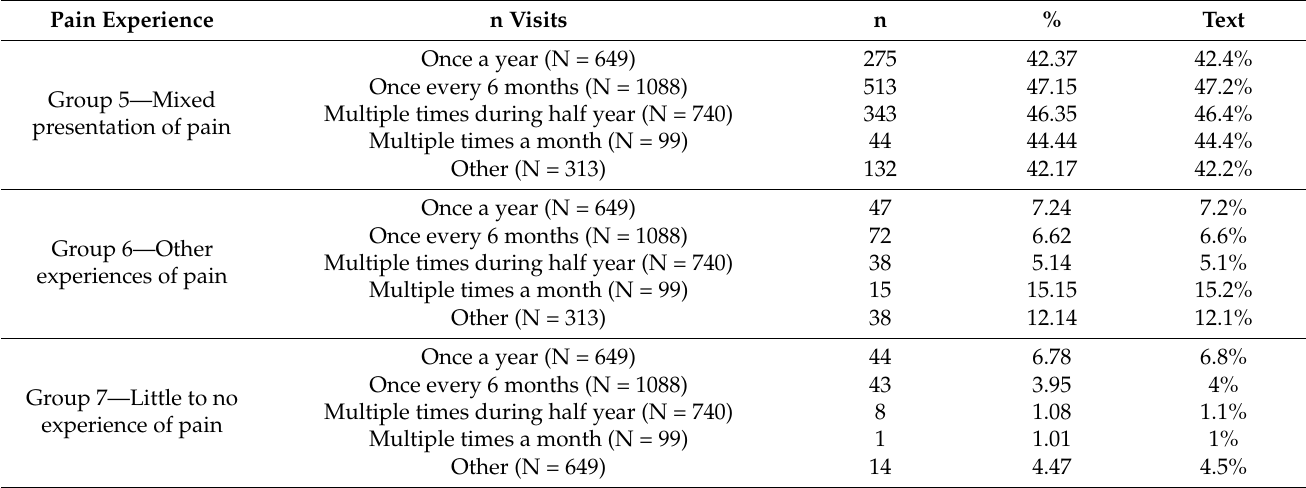
Table 5 and Figure 4 depict the stage of endometriosis in relation to fertility ( p -value: <<0.001). There is a correlation between higher stages of disease and difficulty conceiving, with 23.9% of patients affected by infertility in Stage 1 of the disease, growing to 36.4% in Stage 4. The greatest variation exists between Stage 2 (25.5%) and Stage 3 (34.7%), while no remarkable difference in fertility hardship is seen between Stage 3 and Stage 4 (34.7% and 36.4%, respectively). As the purpose of this analysis was to identify fertility hardship, it did not include the analysis of patients reporting that they had not been trying to conceive or are not currently trying to conceive. Table 5. Fertility abnormalities reported by participants in relation to stage at the time of completing the questionnaire.